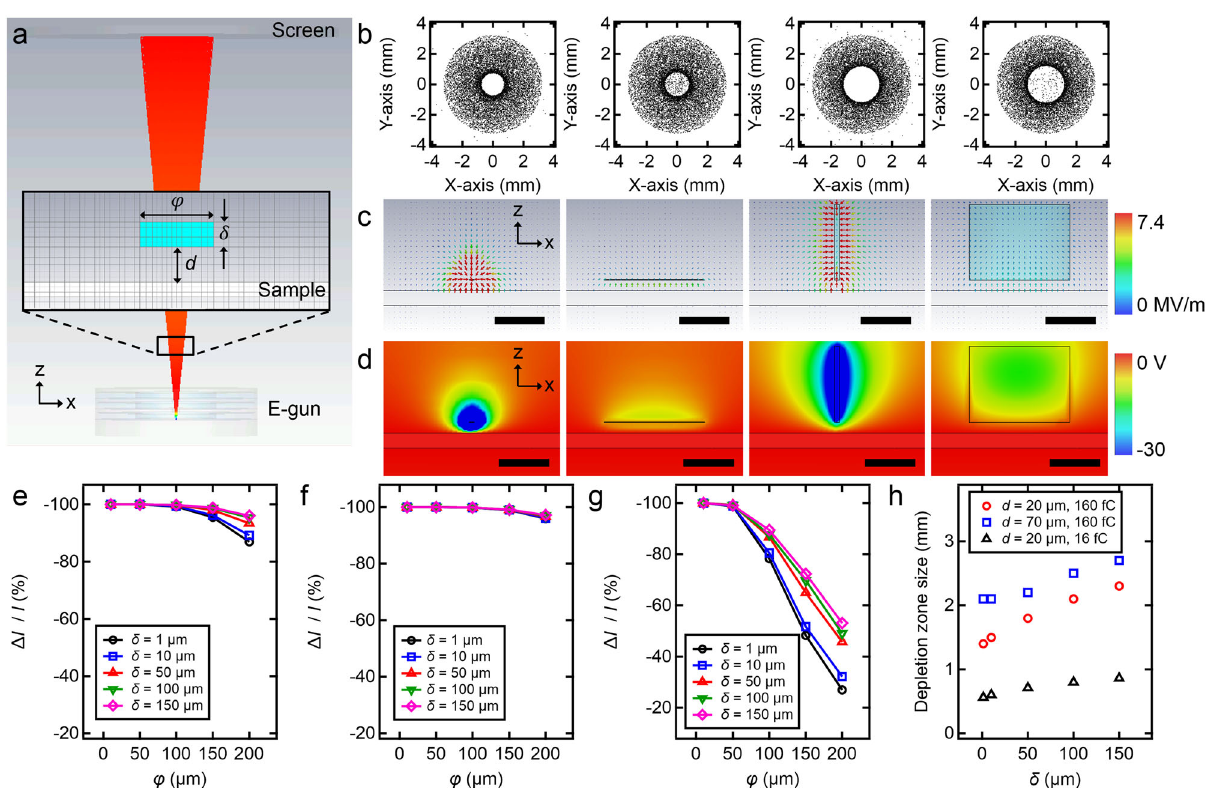
Fig. 4 Simulation study of the surface fi eld effect on electron image. a Simulation model of the experimental geometry including electron gun, sample grid, and screen. The simulated low-energy electrons are colored according to their kinetic energy. The inset shows the magni fi ed view of the charge- separated region where the electron plasma creating the surface fi eld (sky blue color) is modeled as a cylinder with diameter φ and thickness δ , separated from the sample grid by the distance d . b Representative two-dimensional position distributions of low-energy electrons at the screen plane. The modeling parameters of the plasma shape are ( φ = 10 μ m, δ = 1 μ m, d = 20 μ m), ( φ = 200 μ m, δ = 1 μ m, d = 20 μ m), ( φ = 10 μ m, δ = 150 μ m, d = 20 μ m), and ( φ = 200 μ m, δ = 150 μ m, d = 20 μ m), from the left to the right panel, and the plasma charge is 160 fC. c Corresponding electric fi eld map to panels shown in b in respective order and d electric potential distribution in the charge-separated region to the same panels shown in b in respective order. The scale bar indicates 100 μ m. Δ I / I in the depletion zone as a function of φ and δ for the plasma charge of 160 fC and d = 20 μ m ( e ), 160 fC and d = 70 μ m ( f ), and 16 fC and d = 20 μ m ( g ). h Depletion zone size at the screen plane as a function of δ for different d and plasma